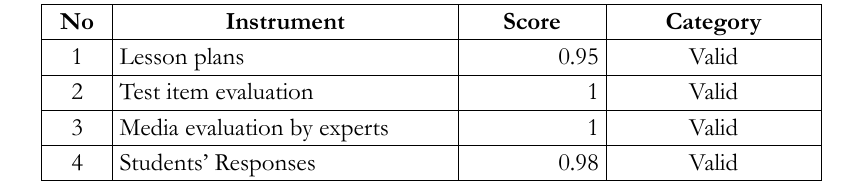
Table 7. Result of Instrument Validation